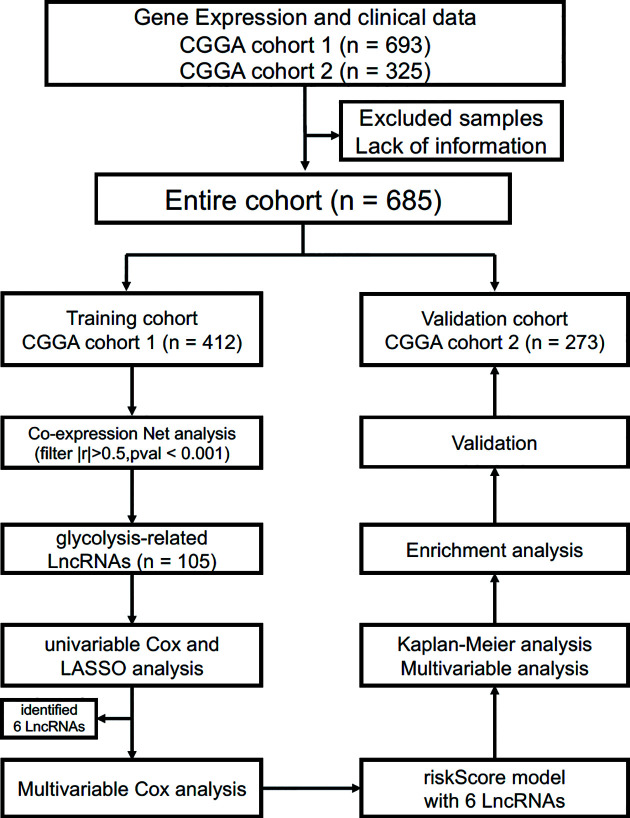
Flow chart of data collection and analysis.